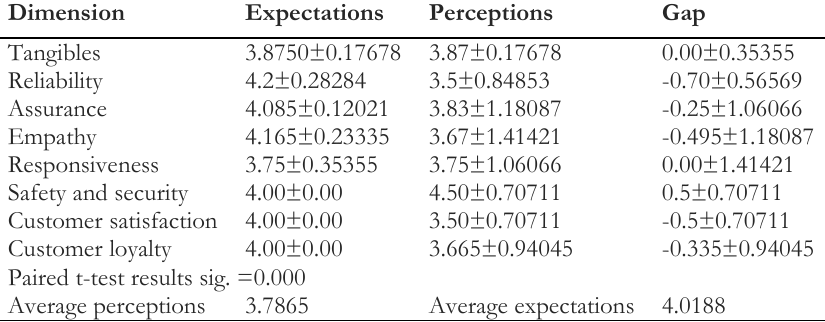
Table 5. Gap quality analysis of reverse support services - unit 2.